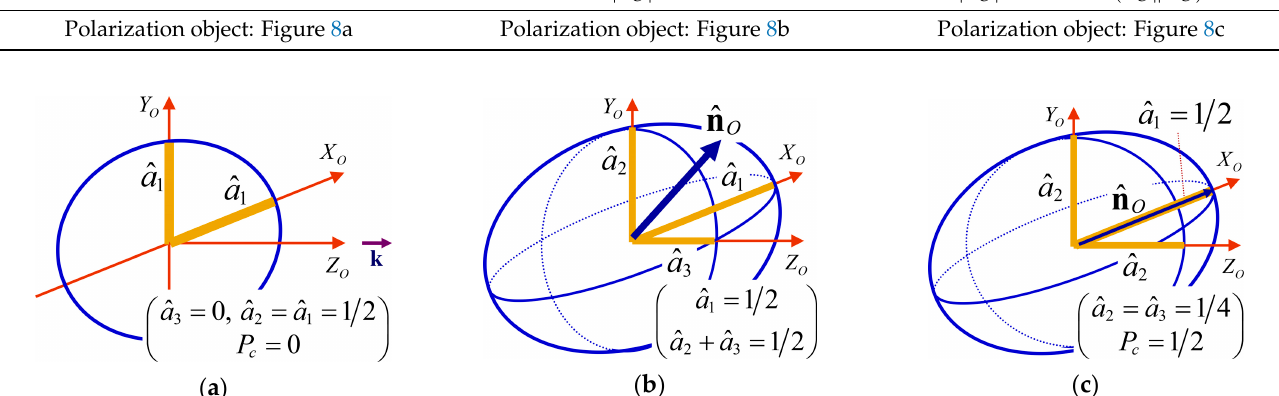
Polarization object: Figure 8a Polarization object: Figure 8b Polarization object: Figure 8c